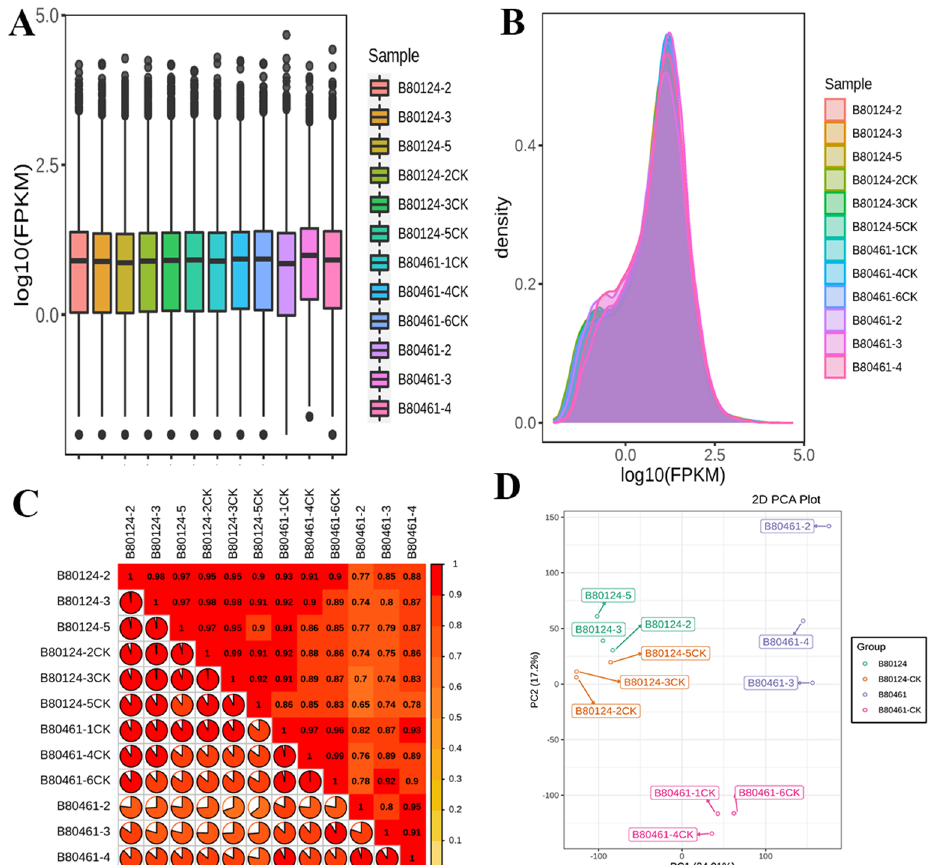
Figure 3. Transcriptome analysis of gene expression. Analyses were performed using the following four methods: fragments per kilobase of the transcript per million fragments mapped (FPKM) ( A ), density map ( B ), Pearson’s correction coefficient (R 2 > 0.8) ( C ), and principal component analysis ( D ).